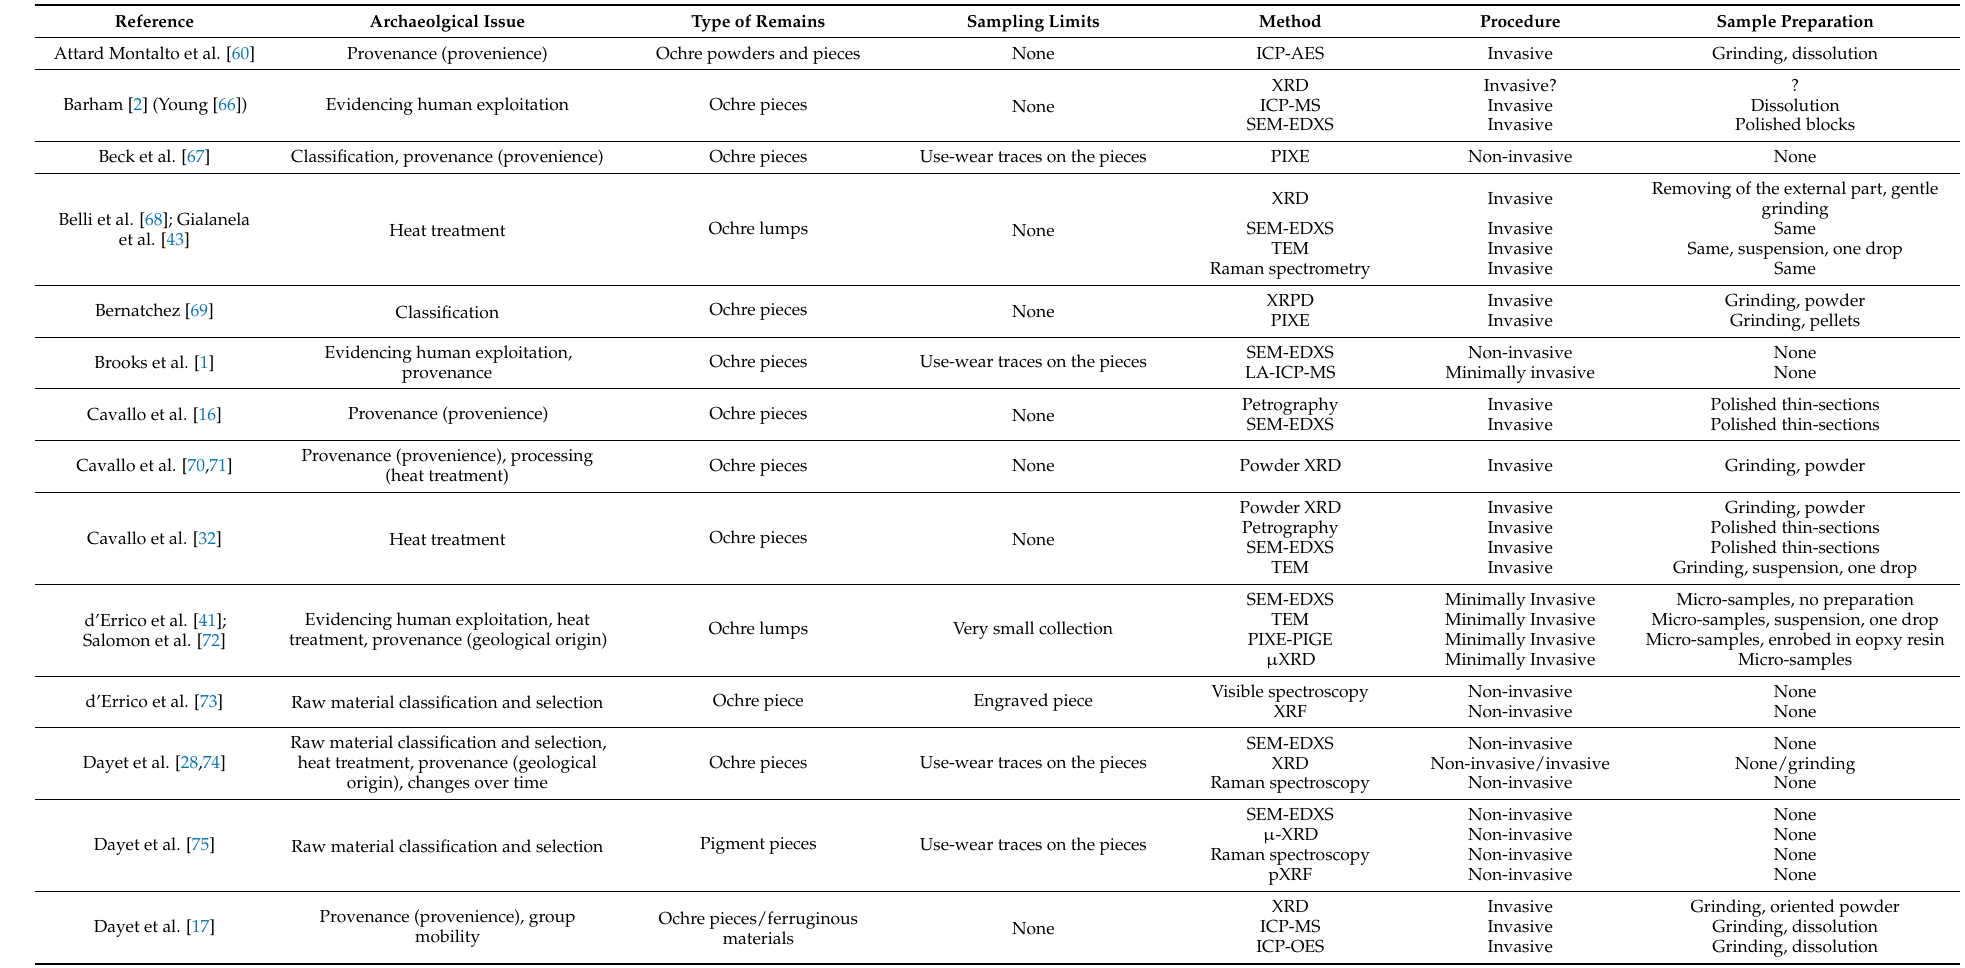
Table 1. Non-exhaustive list and short description of studies dedicated to the characterization of archeological ochre materials (mainly cohesive pieces and sediments) during the last two